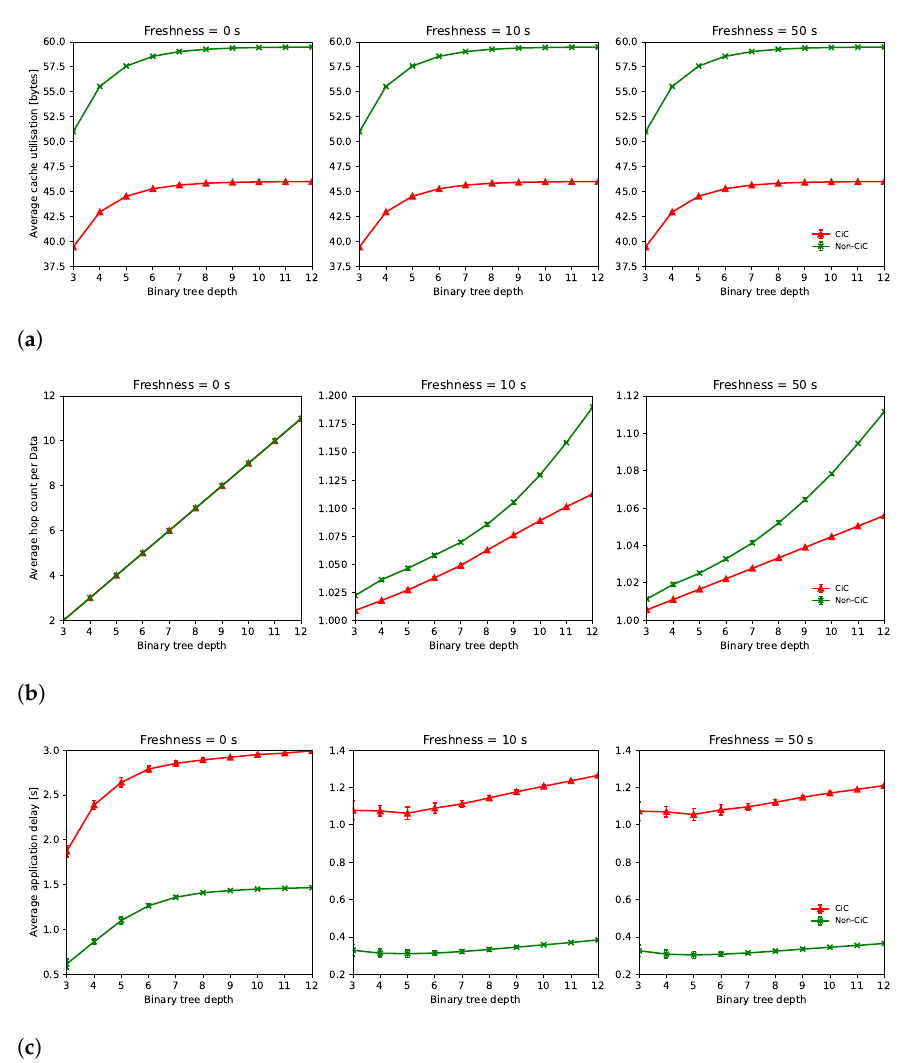
Figure 8. Evaluation results for different metrics and freshness values: ( a ) Average cache utilisation; ( b ) Average number of hops per data packet; ( c ) Average application level